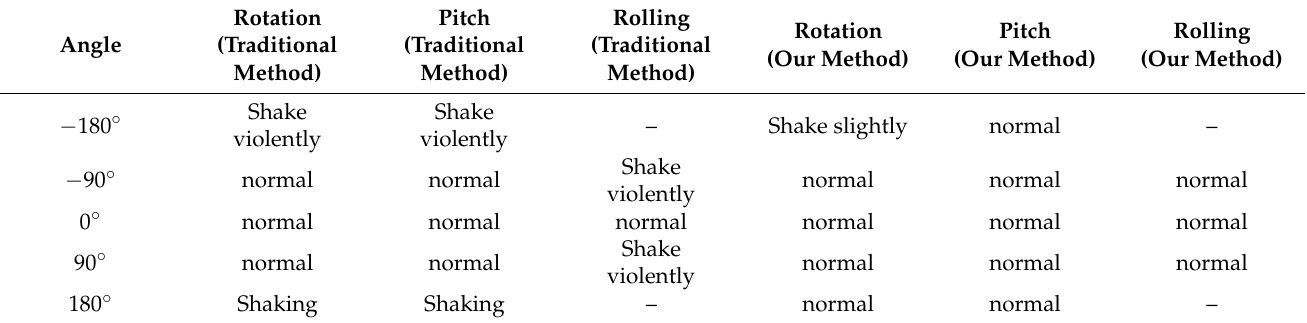
Table 3. Test results for common operations in AR maps at extremes at different